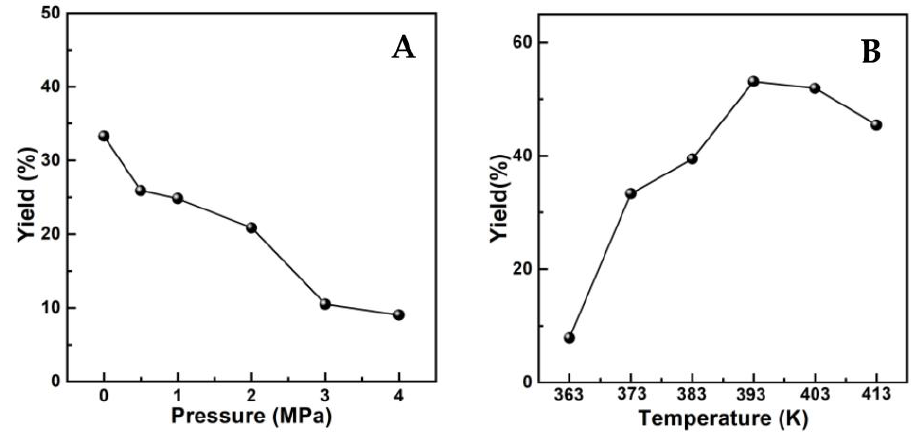
Figure 3. ( A ) Effect of H 2 pressure on UE yield. Reaction conditions: 1 mmol CA, 50 mg catalyst, 120 min, 373 K; ( B ) Influence of reaction temperature on UE yield. Reaction conditions: 1 mmol CA, 50 mg catalyst, 120 min, 0.1 MPa H 2 .